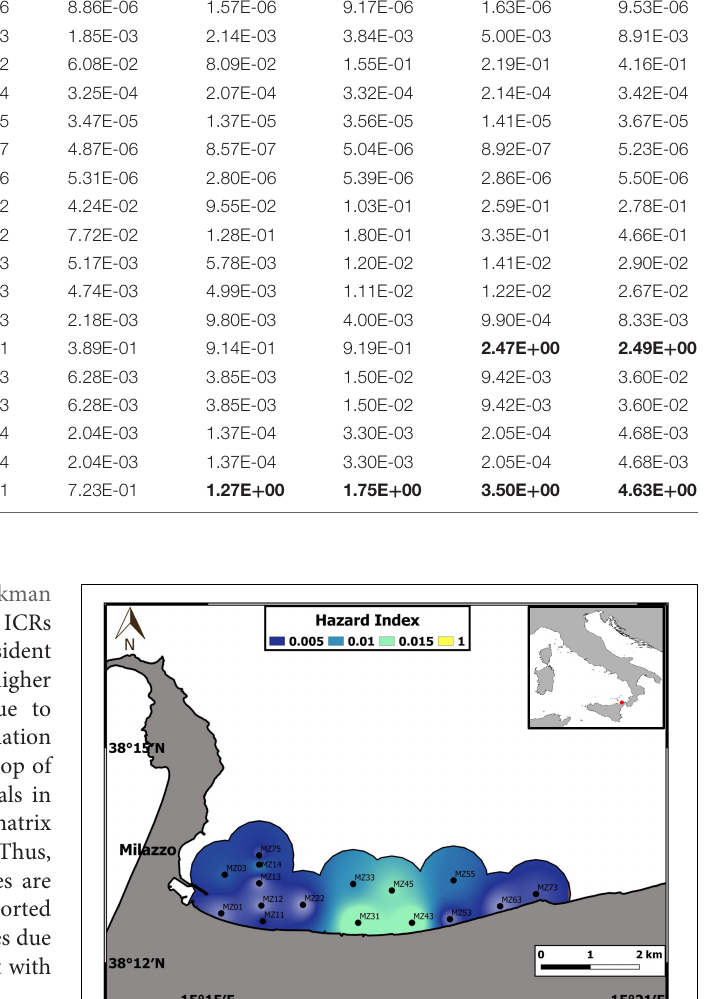
upper bound of EPA acceptable range (2.7 · 10 − 4 for the